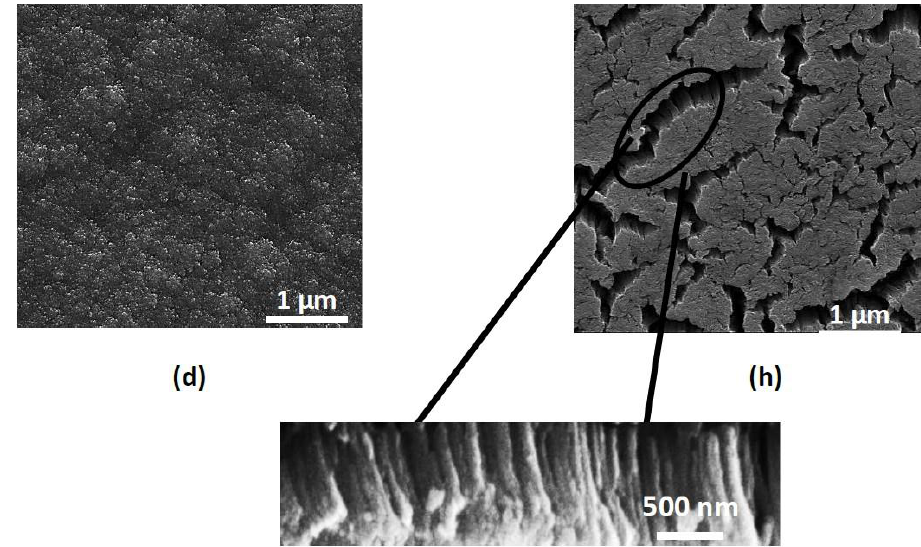
Figure 3. Scanning electron microscopy images of alloyed ( a – d ) and dealloyed ( e – h ) catalyst at various Cu alloying sputtering powers: ( a ) 30 W; ( b ) 50 W; ( c ) 100 W; ( d ) 200 W; ( e ) 30 W; ( f ) 50 W; ( g ) 100 W; ( h ) 200 W, where the sputtering power of Ru is kept as 50 W.